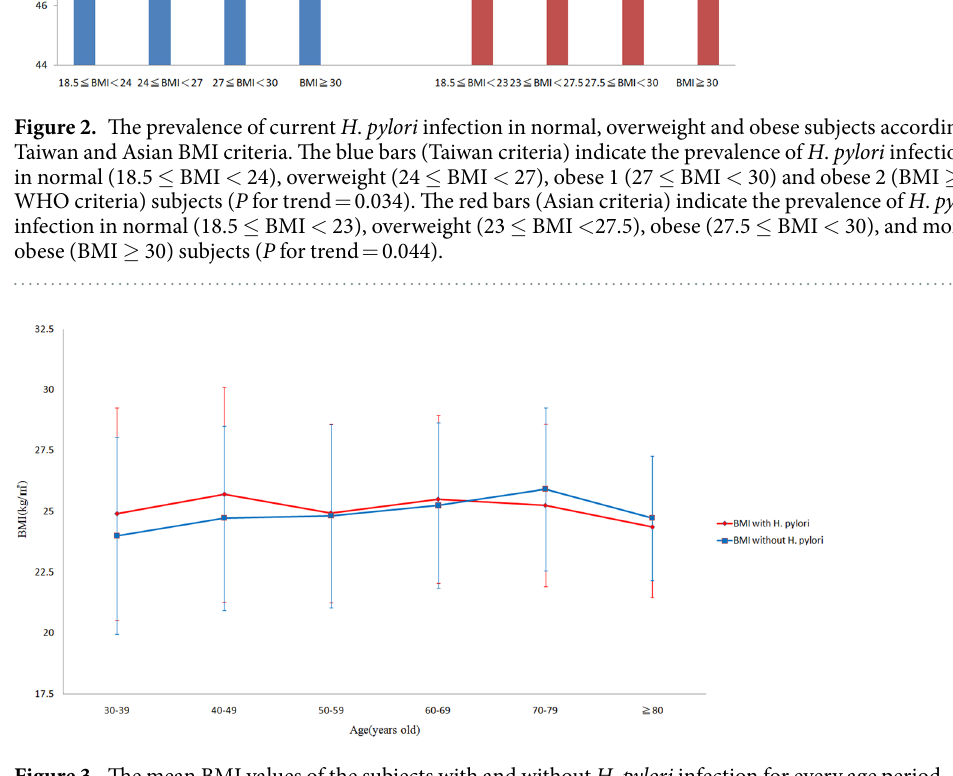
Figure 3. The mean BMI values of the subjects with and without H . pylori infection for every age